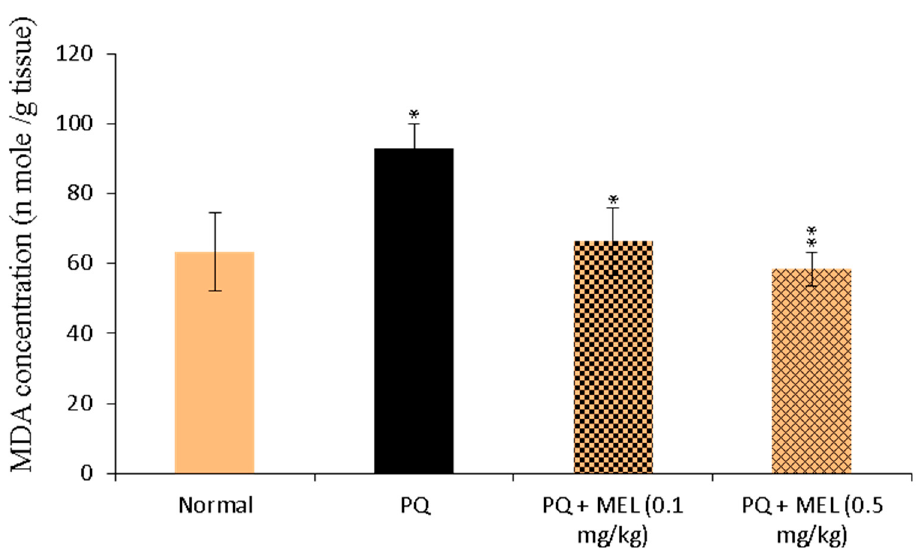
Figure 2. Effect of treatment with melittin (MEL) on the levels of malonaldehyde (MDA) in lung tissue homogenate. MDA (lipid peroxidation index) levels were determined in the lung tissue homogenate using MDA colorimetric assay. The absorbance of the formed product was measured at 534 nm. The results were expressed as nmol MDA per g tissue. Data are presented as mean ±SD. Significantly (* p < 0.05, ** p < 0.01) different from PQ group.